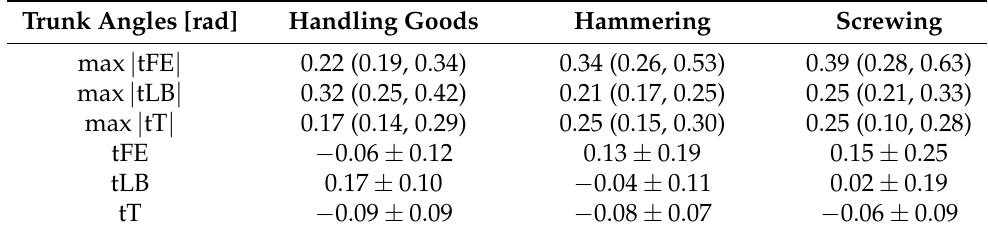
Table 4. Interquartile ranges of the maximum trunk rotations and mean and standard deviation of the trunk compensatory movements computed for all the trials recorded from the eight enrolled